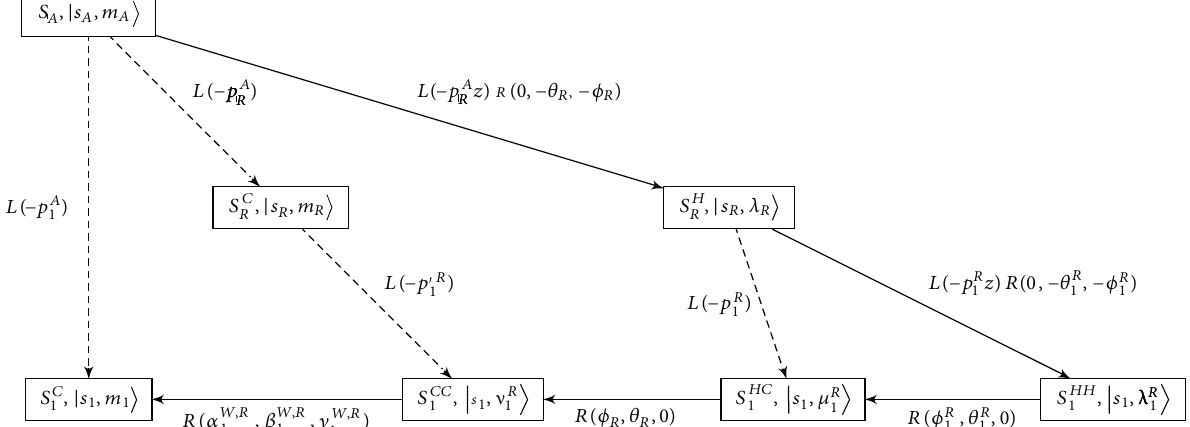
Figure 1: Graphical summary of the spin state de fi nitions associated with the decay amplitude for fi nal particle 1 and intermediate state R . The solid lines indicate the Lorentz transformation sequence involved in the writing of the helicity amplitude. Once a conventional choice for j s A , m A i initial A particle spin states is set, all the other spin states are completely speci fi ed by their Lorentz transformation sequence. Momentum labels of spin states have been suppressed to avoid cluttering the